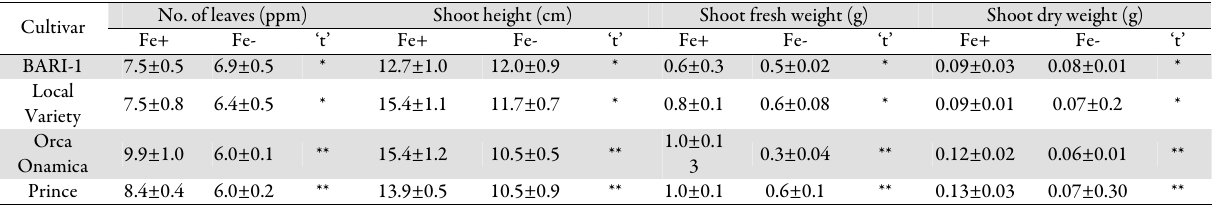
‘t’ test: *Statistically non-significant; **Statistically significant